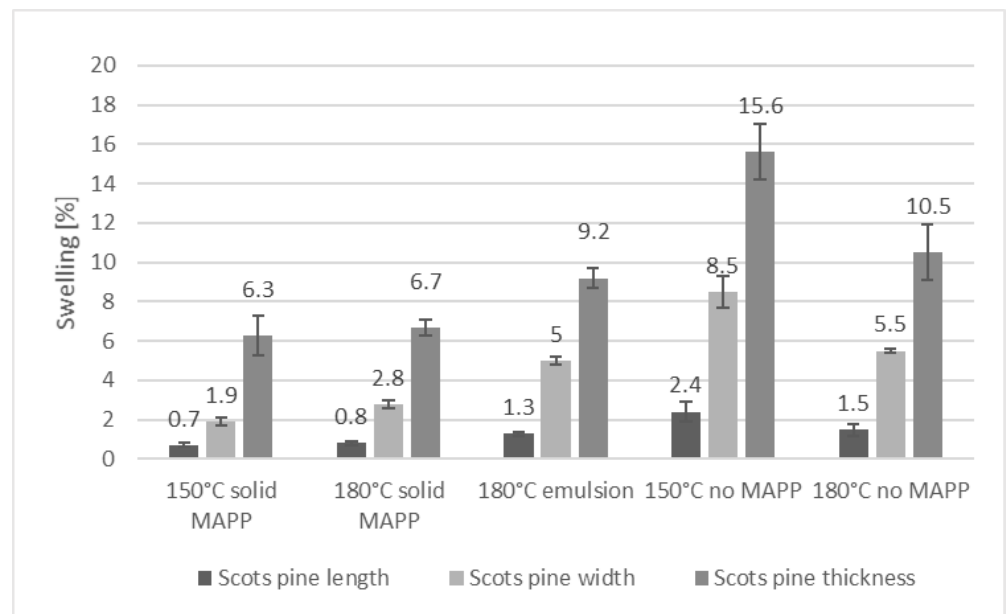
Figure 8. Swelling of composites with TMP based on Scots pine after five hours submersion in boiling water. For comparison, values for composites with wood flour (softwood) were 0.3% (length), 0.7% (width) and 3.5% (thickness) including MAPP (solid), and 2.3% (length), 8.2% (width) and 16.0% (thickness) excluding MAPP.